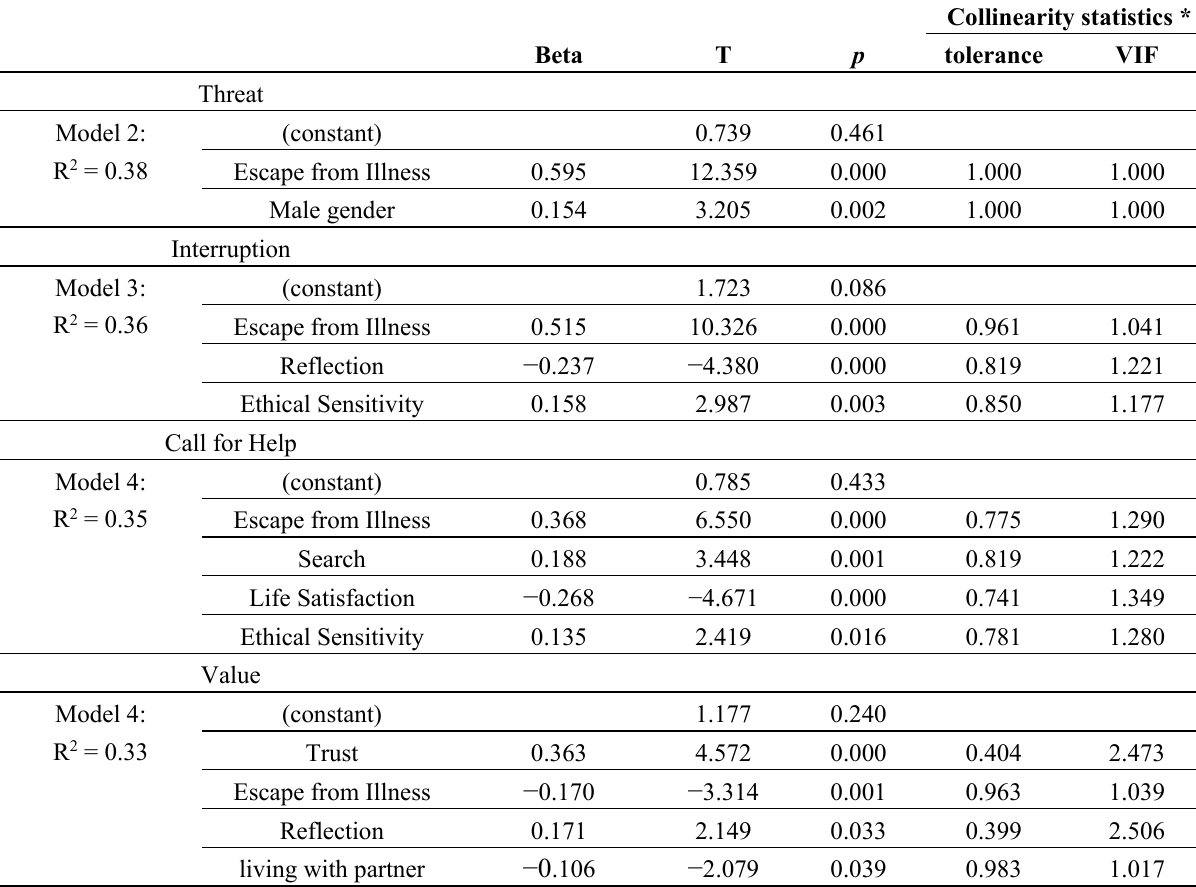
Table 6. Predictors of interpretations of illness (stepwise regression